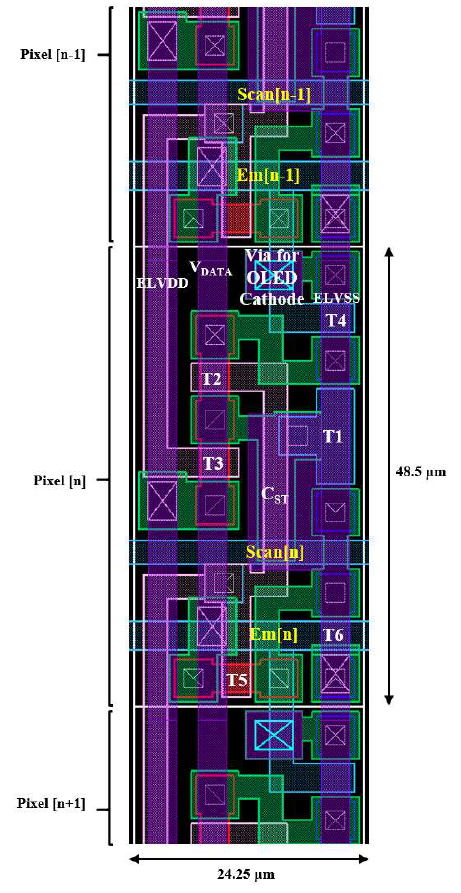
Figure 8. The layout of the proposed 6T1C pixel circuit.